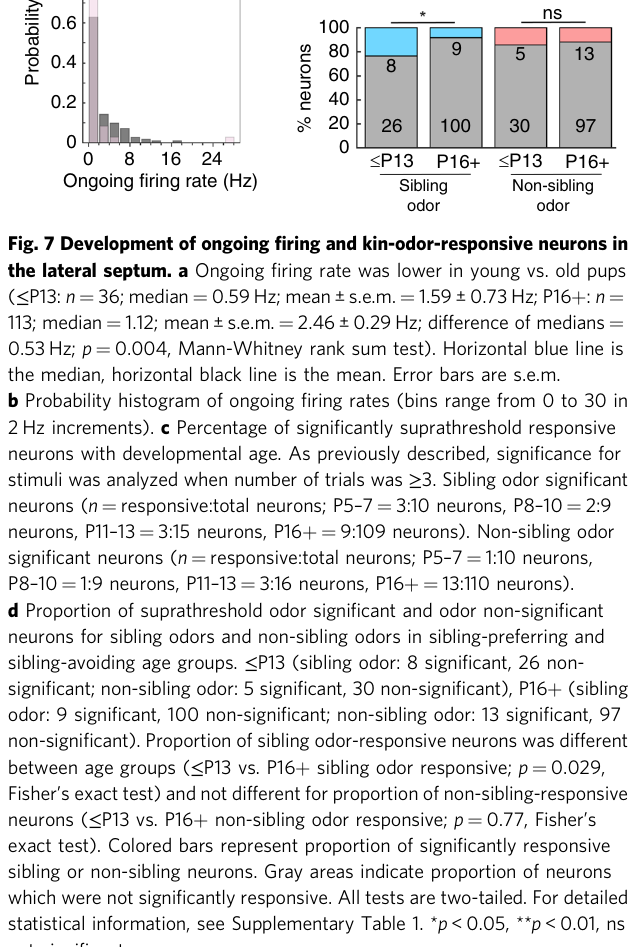
dorso-ventral organization 17 , which may underlie the selective responsiveness to odor stimuli to kin in the intermediate region.